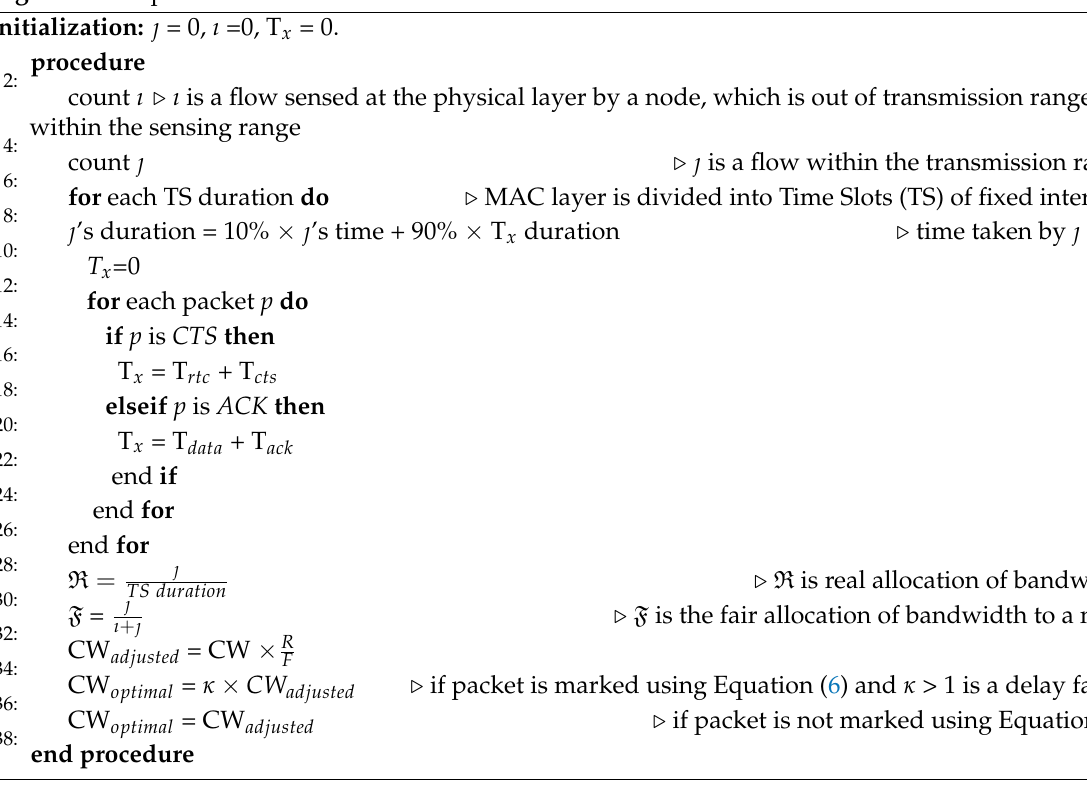
Algorithm 2 Optimal Contention Window Selction